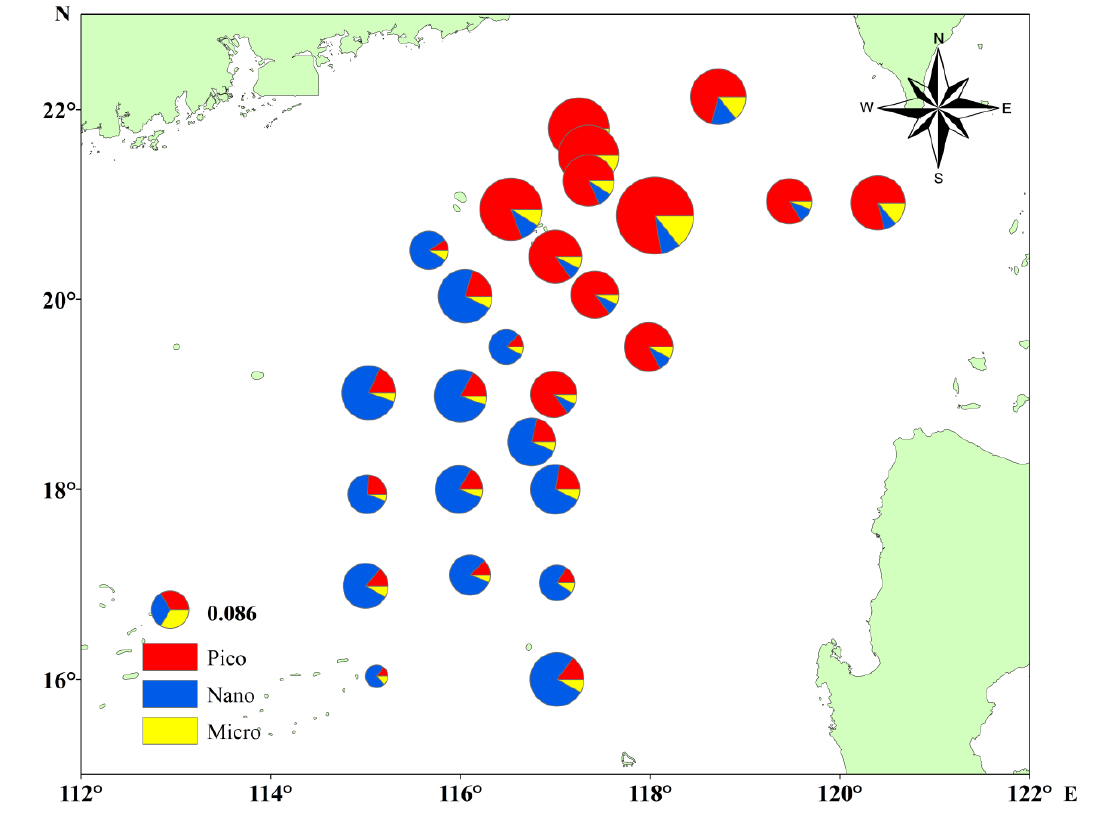
Figure 4. Pie chart of size-fractionated Chl a bases on water column integration. The size of the pie chart is related to the phytoplankton biomass.